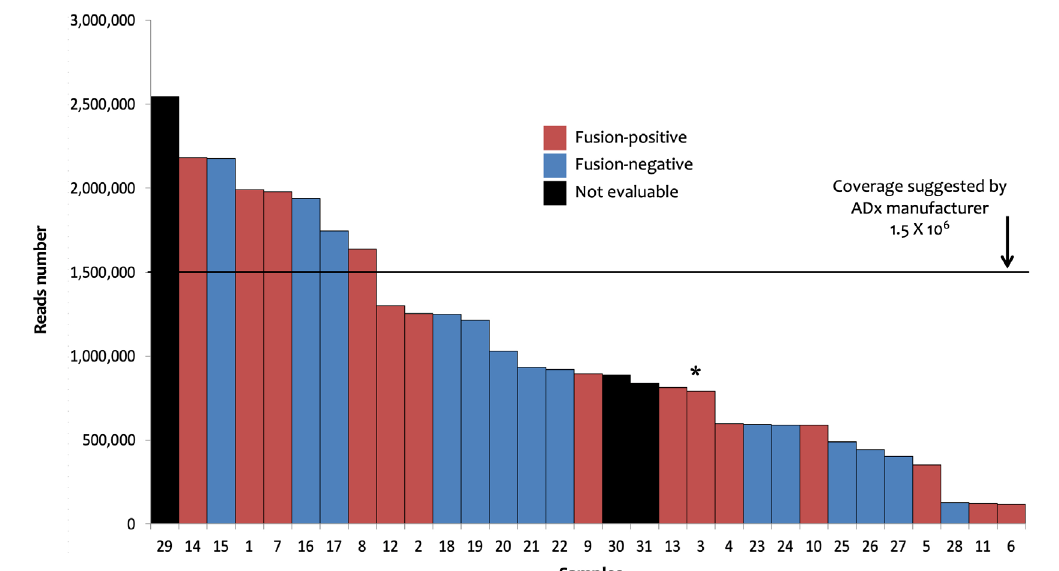
Figure 1. Sarcoma panel: ADx results. The 31 samples investigated with sarcoma panel and analyzed by ADx are shown ordered on the basis of the number of the reads. Sample 3 (marked by the asterisk) showed the EWSR1-TFCP2 fusion coupled with an ALK large deletion (∆2-18) as well as ALK unbalanced